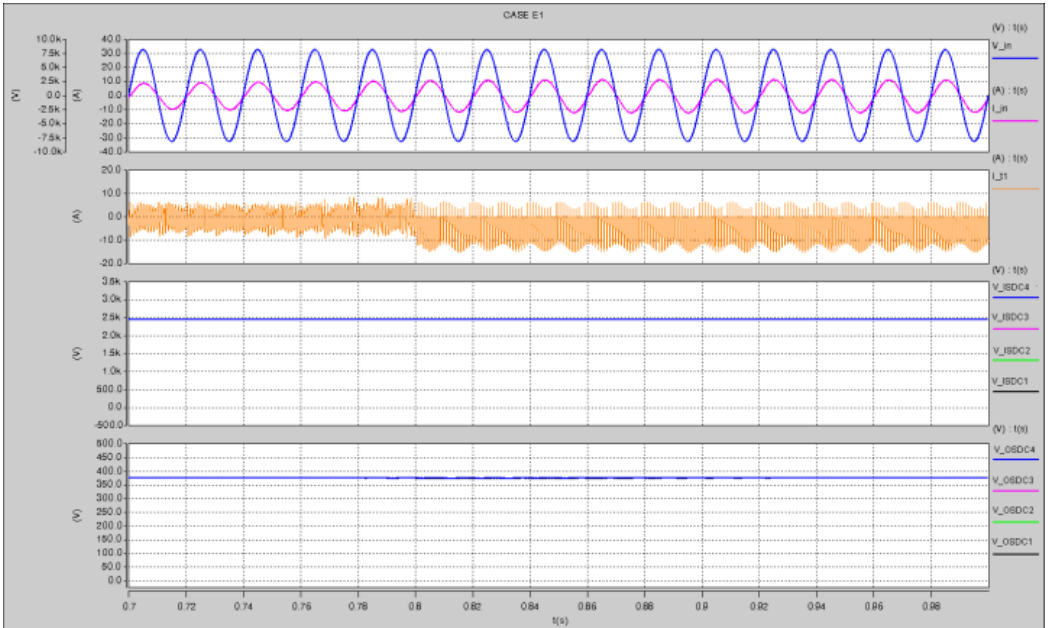
Figure 18. Simulation results of fault E1.